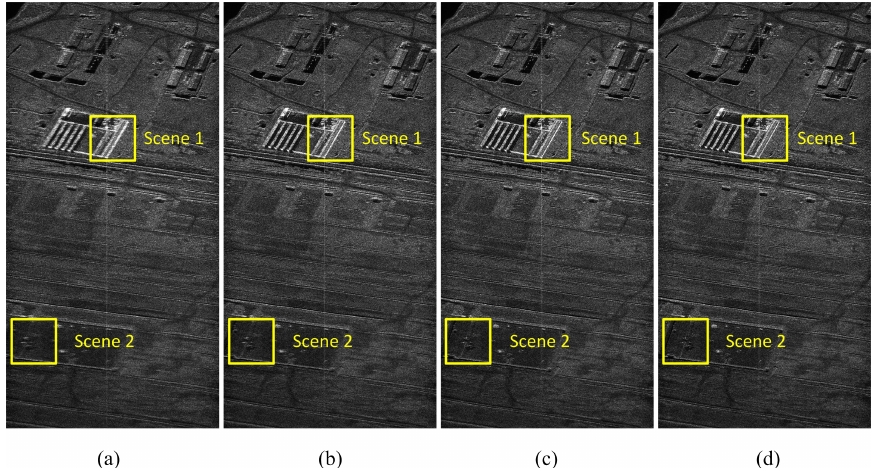
Figure 18. Ka-band airborne SAR Images processed by different autofocus strategies. ( a ) Processed with INS-only MOCO. ( b ) Processed with conventional MDA. ( c ) Processed with RDMDA. ( d ) Processed with